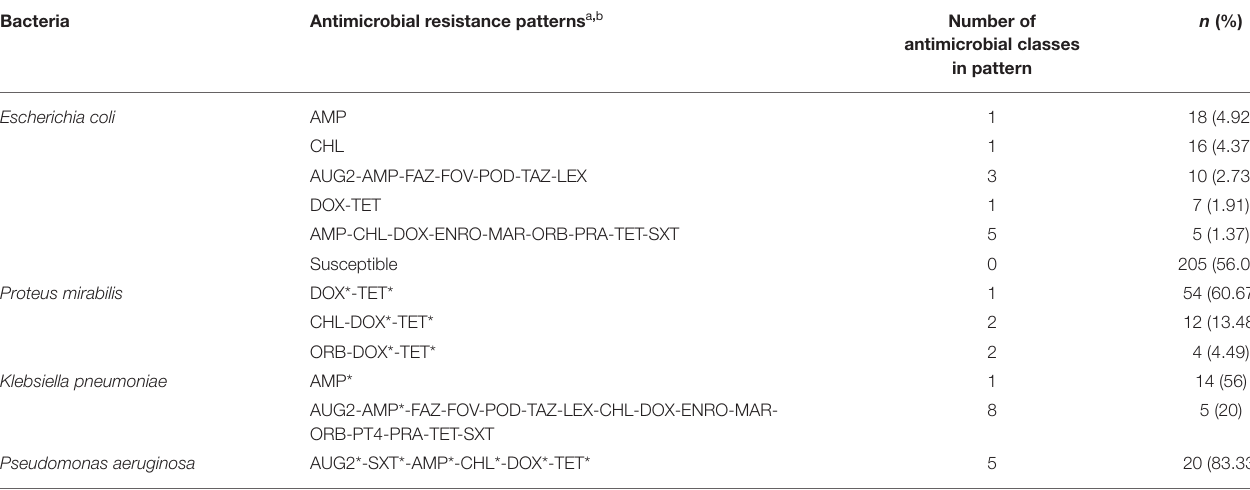
TABLE 6 | The most common antimicrobial resistance patterns of Gram-negative bacteria isolated from canine urine samples. Bacteria Antimicrobial resistance patterns a , b Number of